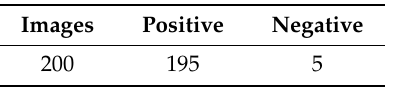
Table 2. Euro banknote recognition results for 200 real banknote images in order to calculate the hit rate of the system.